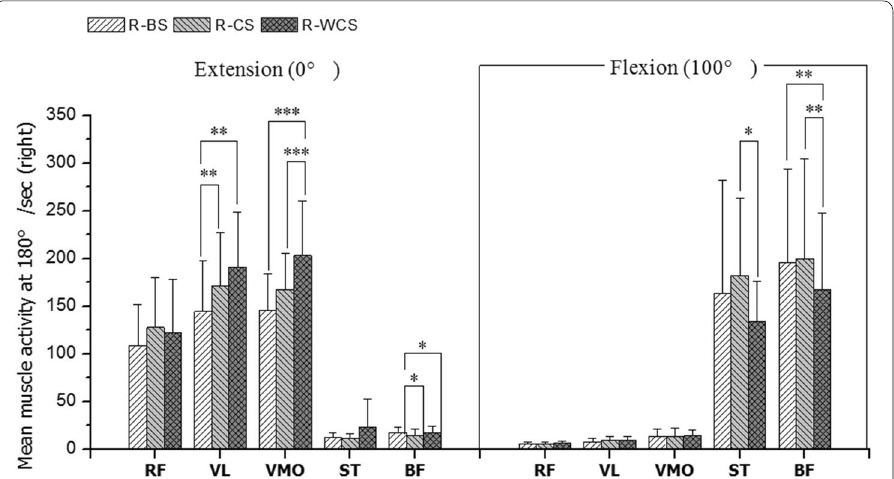
Fig. 6 Mean muscle activities of the right legs at the angular velocity of 180°/s: left (during knee extension); right (during knee